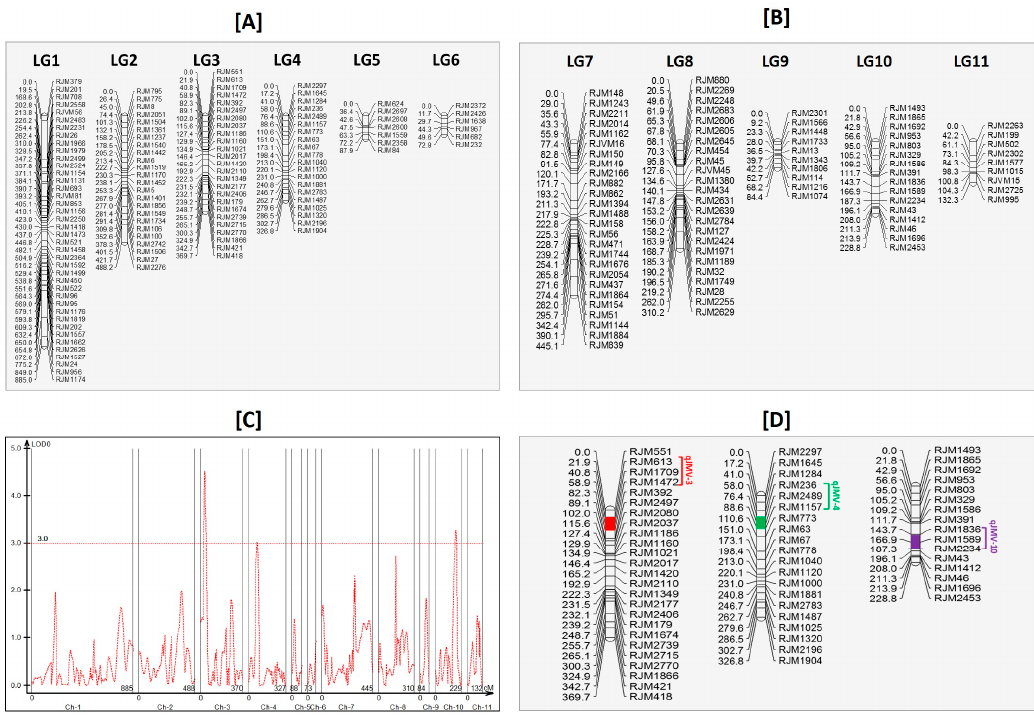
Figure 3. An interspecific genetic linkage map ( A ) LG1–LG6; ( B ) LG7–LG11 of Jatropha curcas based on an F 2 mapping population generated by crossing J.curcas × J. integerrima . Estimates of map distances between markers are indicated in Kosambi centimorgans; ( C ) Whole genome scan of quantitative trait loci (QTLs) for Jatropha Mosaic Virus (JMV) resistance in Jatropha linkage maps. The X axis represents the distance in centimorgans (cM), and the Y axis depicts the logarithm of the odds (LOD) score. The red horizontal dotted line represents a significance LOD threshold value of 3.0; ( D ) Summary of three minor QTL locations detected in the genome of Jatropha . QTLs, represented by bars, are shown on the left side of the linkage groups.